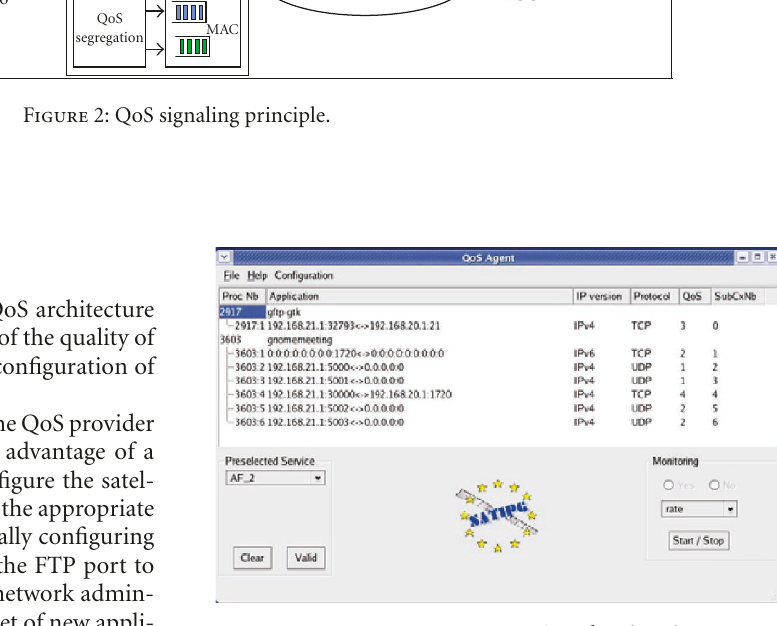
Figure 3: QoS agent user interface